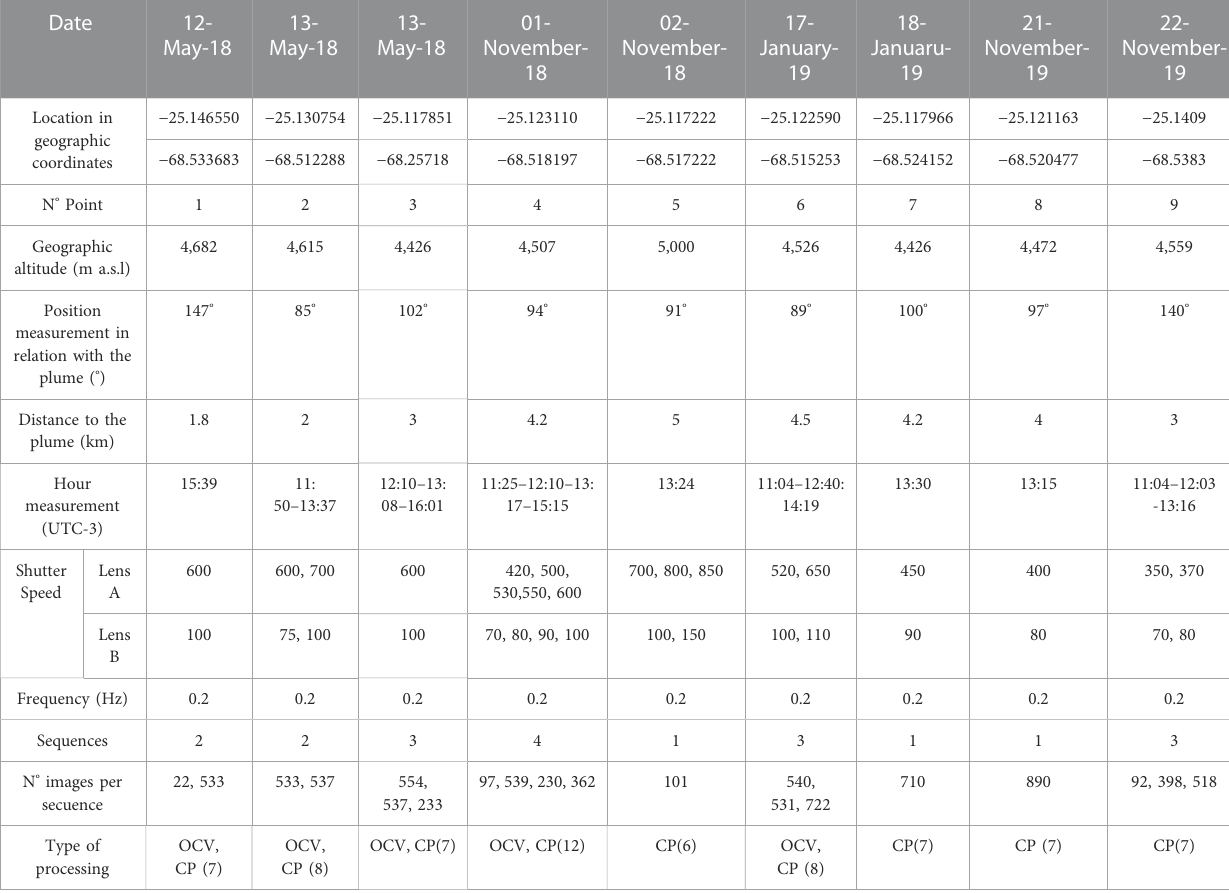
TABLE 1 Technical information about measurements with PiCam, coordinates in decimal degrees, m a.s.l.: meters about sea level, OCV: openCV method for post processing. CP: control points method for post processing (N ° of control points